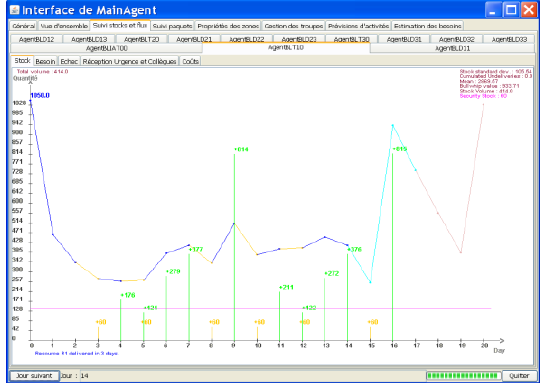
Fig. 11. Stocks evolution for AgZ21 after scheduling